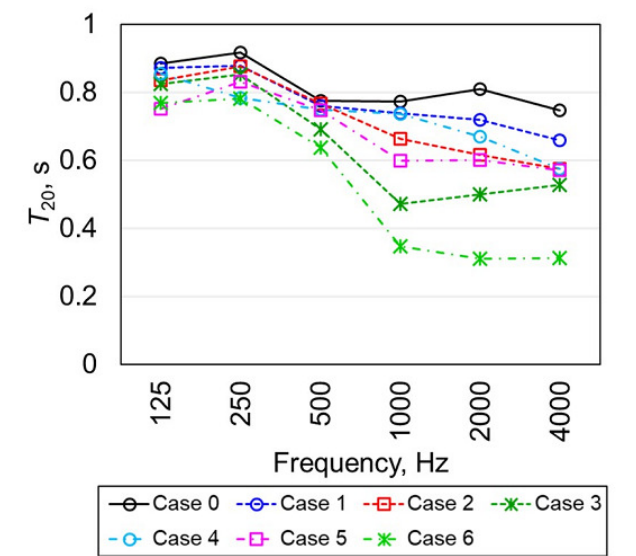
Figure 10. Spatially averaged reverberation time, T 20 s, in a small meeting room for cases